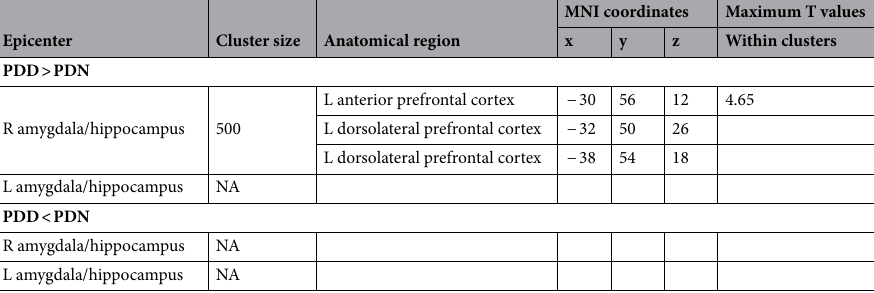
Table 2. Connectivity interactions between PDD and PDN with epicenters. GMV gray matter volume, R right, L left.